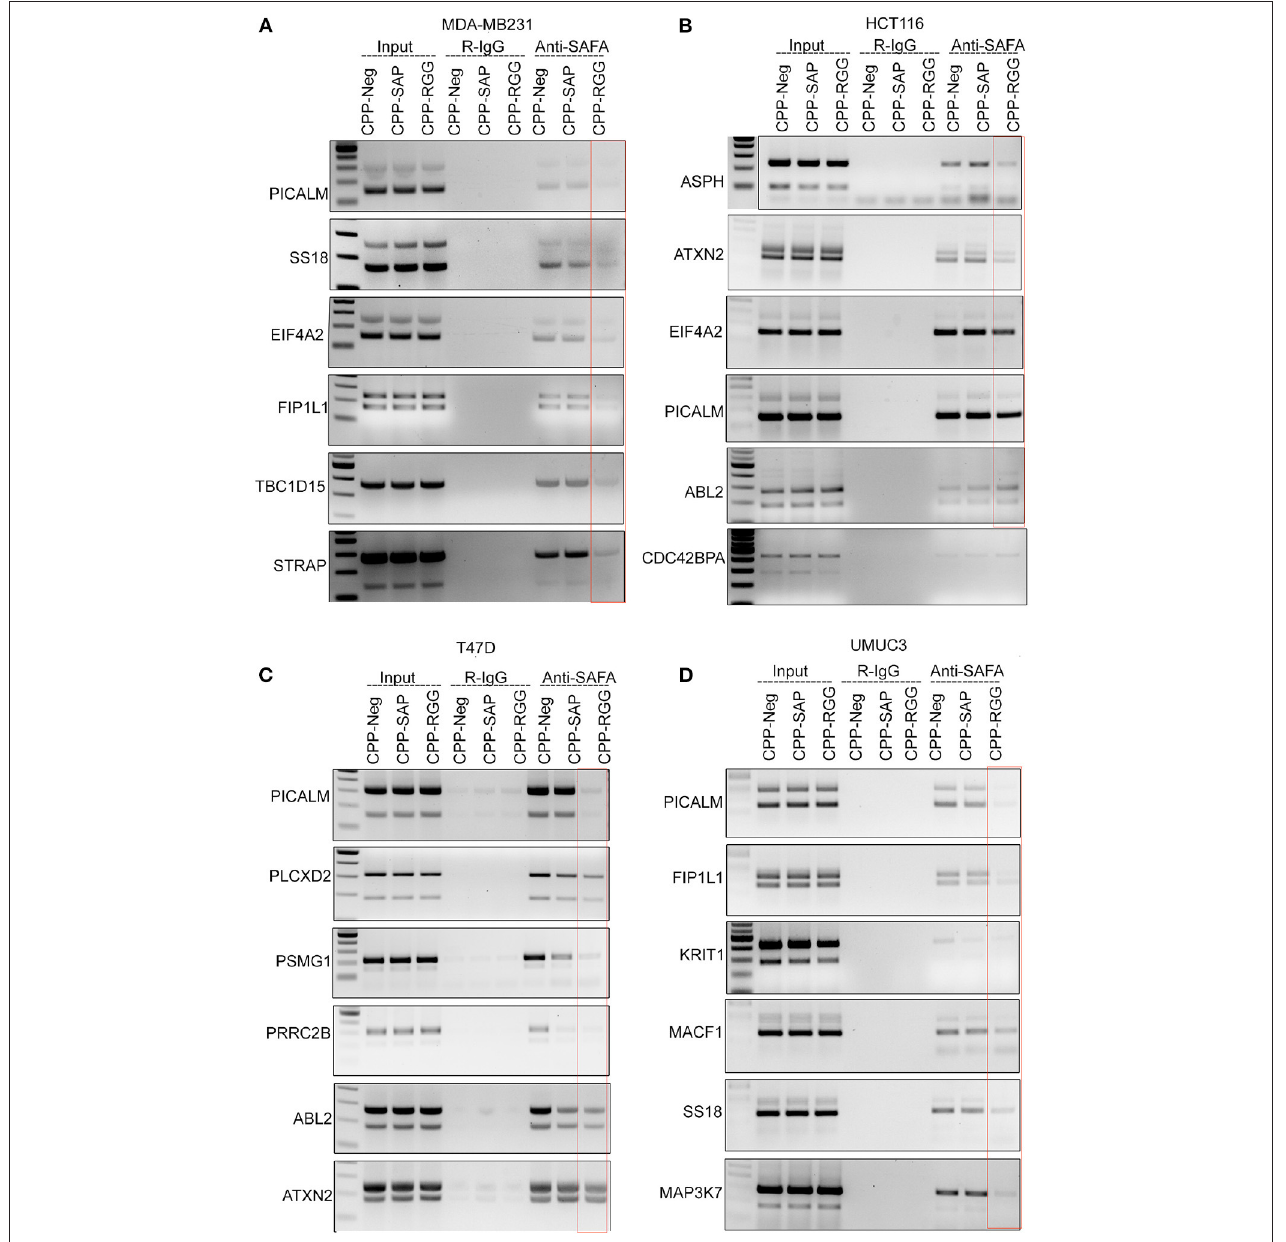
FIGURE 4 | CPP-RGG and CPP-SAP disrupt endogenous SAFA association with specific mRNAs and spliceosome components. (A–D) Crosslinked RNA-IP (CLIP) with anti-SAFA and R-IgG followed by RT-PCR for transcript detection. Red box highlights the lack of SAFA interaction with specific transcripts in CPP-RGG treated cells. * p < 0.05, ** p < 0.01 relative to